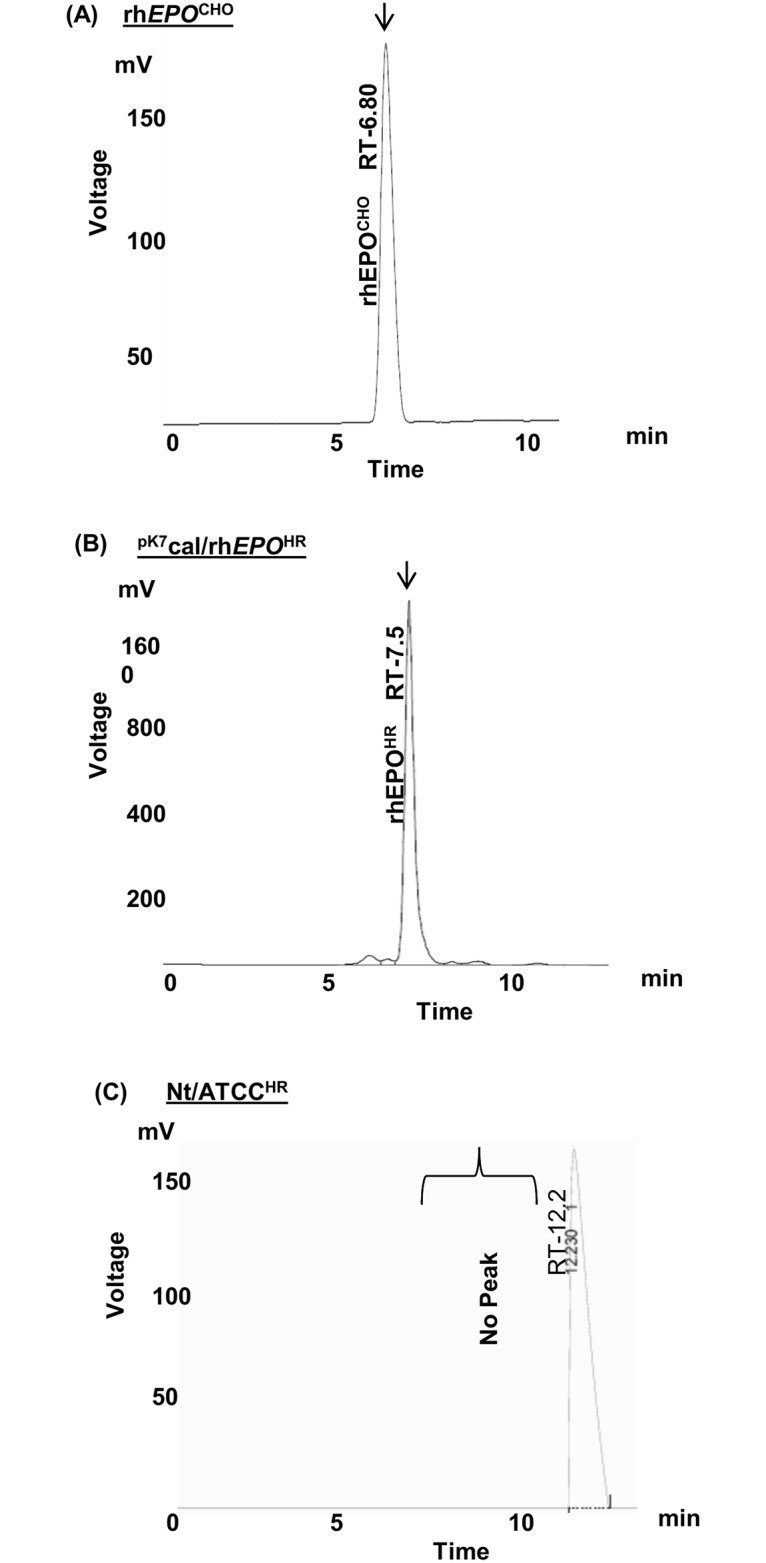
HPLC profile of rhEPO in transformed and control hairy root cultures.(A) Positive control rhEPOCHO standard recombinant human erythropoietin from CHO cells. (B) Hairy root culture pK7cal/rhEPOHR. (C) Negative control hairy root culture Nt/ATCCHR. The arrow indicates the presence of peaks.